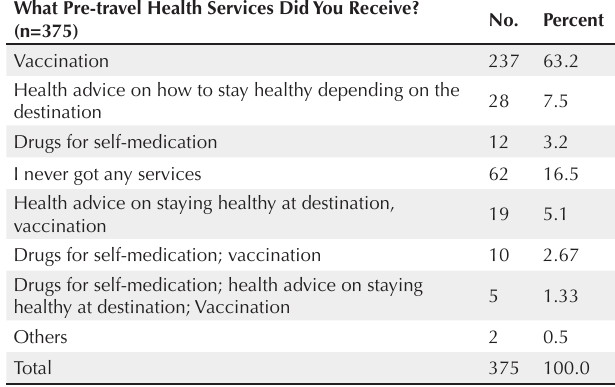
Table 8. Pre-travel Health Services Received by International Travelers